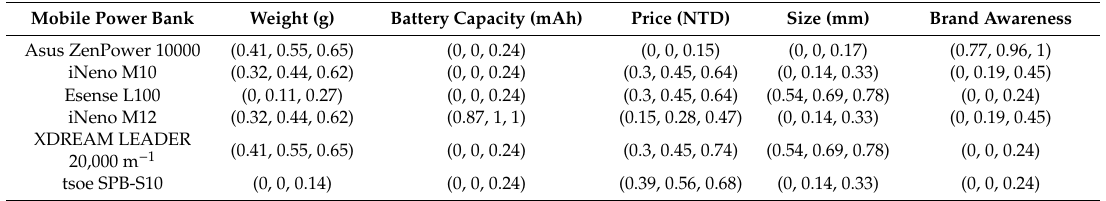
Table 4. Normalized performances.